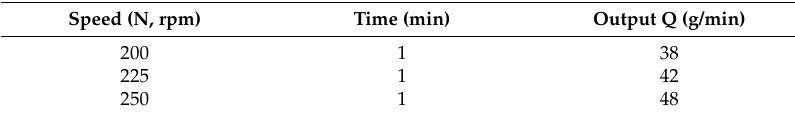
Table 4. Experimental